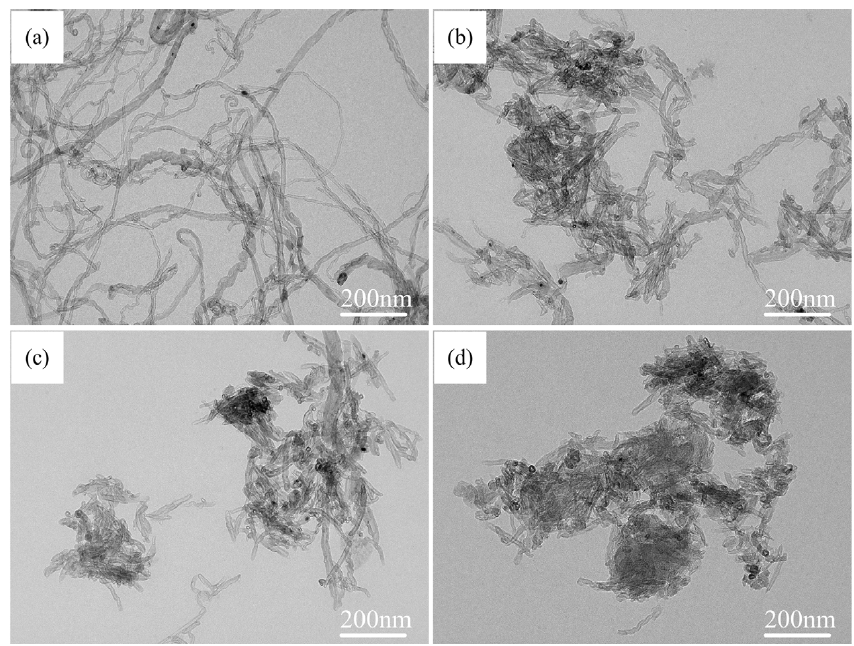
Figure 1. Transmission electron microscopy (TEM) images of ( a ) untreated CNTs and CNTs milled for ( b ) 1 h; ( c ) 2 h and ( d ) 3 h.